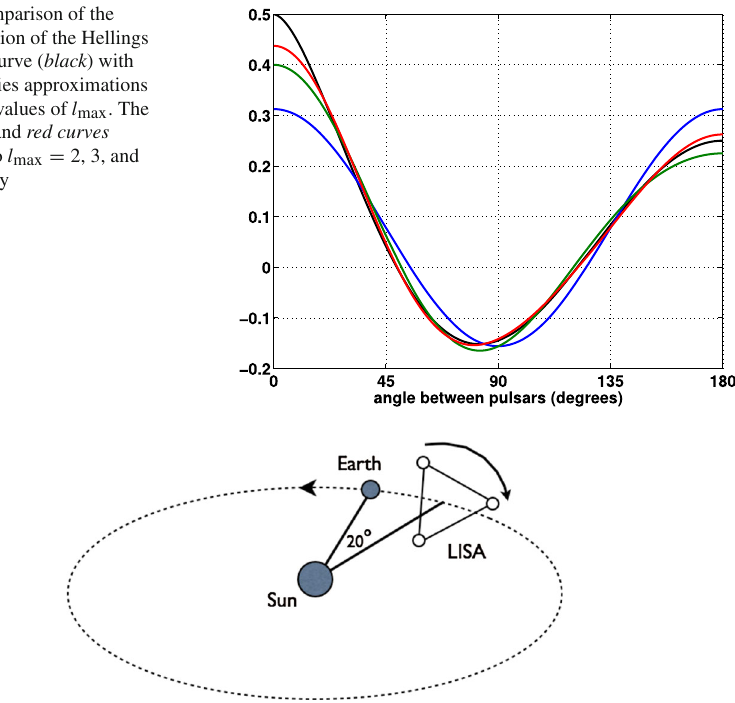
Fig. 39 Original LISA configuration: the center-of-mass of the equilateral-triangle configuration of space- crafts orbits the Sun in a circle of radius 1 AU, 20 ◦ behind Earth, while the configuration ‘cartwheels’ in retrograde motion about the center-of-mass, also with a period of 1year. [Figure adapted from Cornish and Larson